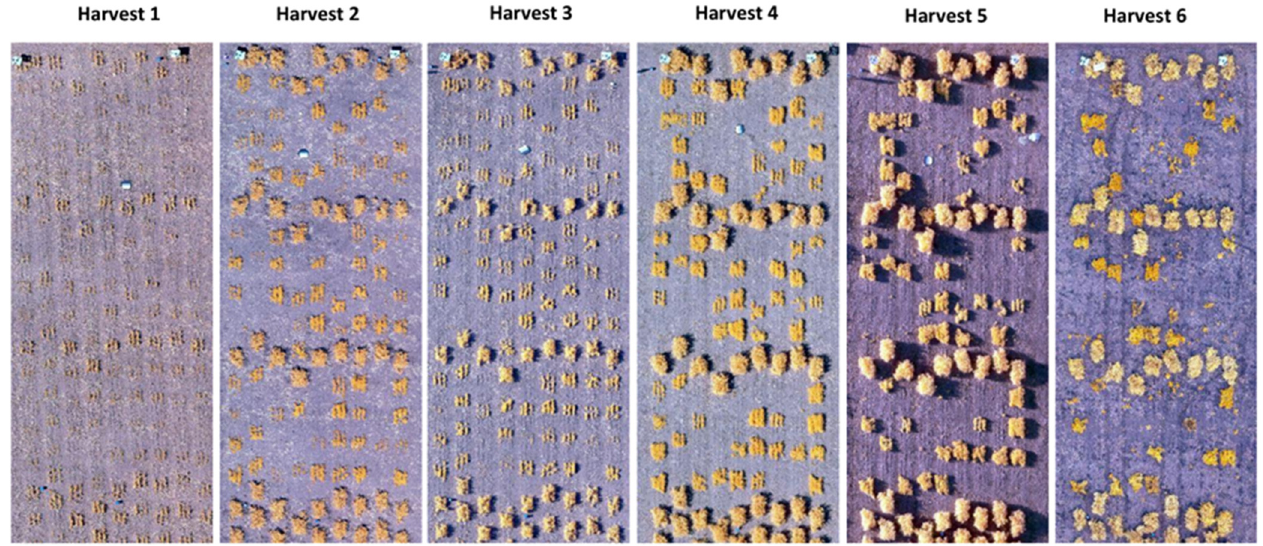
Figure 7. Six orthomosaics represent six biomass harvest time points. Whole-plot biomass was meas- ured approximately every two weeks throughout the growing season (harvests 1 to 6), with aerial images collected within 24 h prior to destructive sampling. Six diverse lentil genotypes were grown in a Randomized Complete Block Design (RCBD) with three replicates in five site years. Larger plots in each orthomosaic are pea plots used to separate replicates.